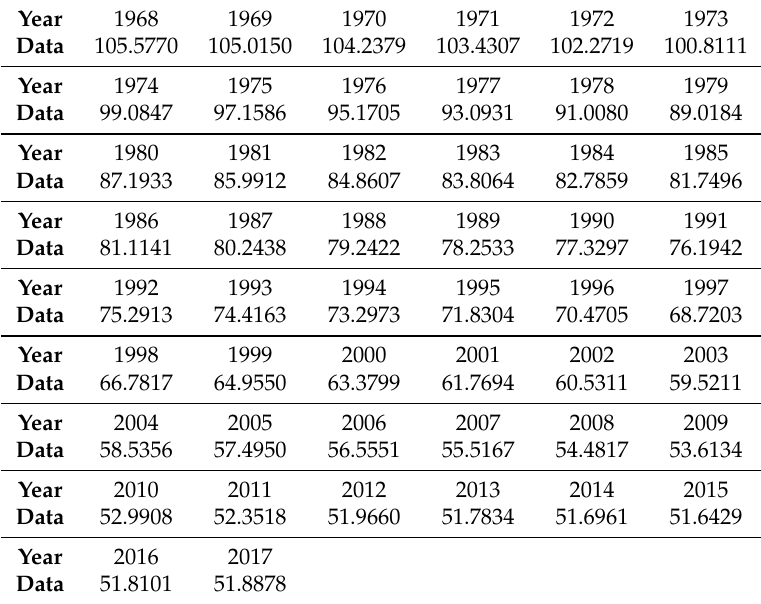
Table 1. Age dependency ratio (% of working-age population) in